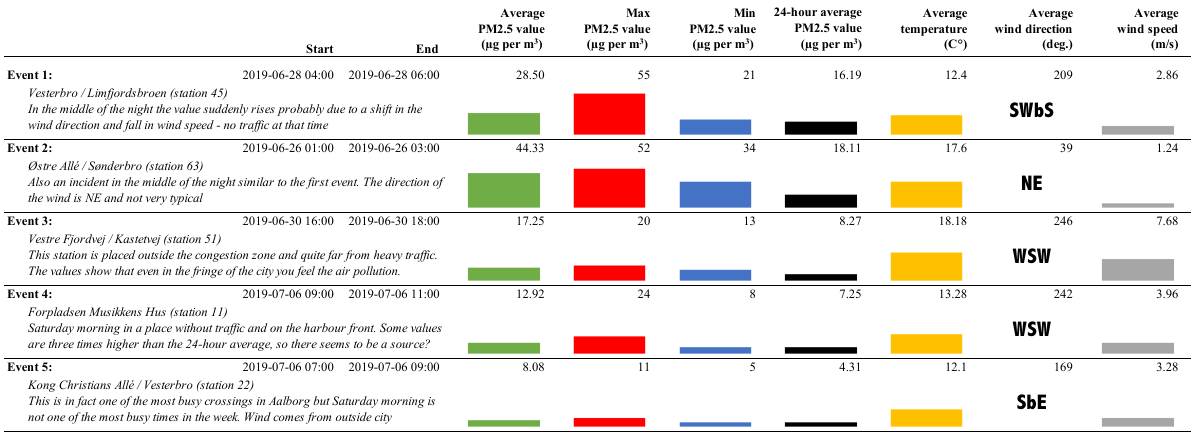
Table 1. Five events in a specific two-week period (25/6/2019 - 09/07/2019) where the level of PM2.5 is different from the normal 24-hour average value. With this report tool it will be possible to compare how different stations perform in the city and to do place- based